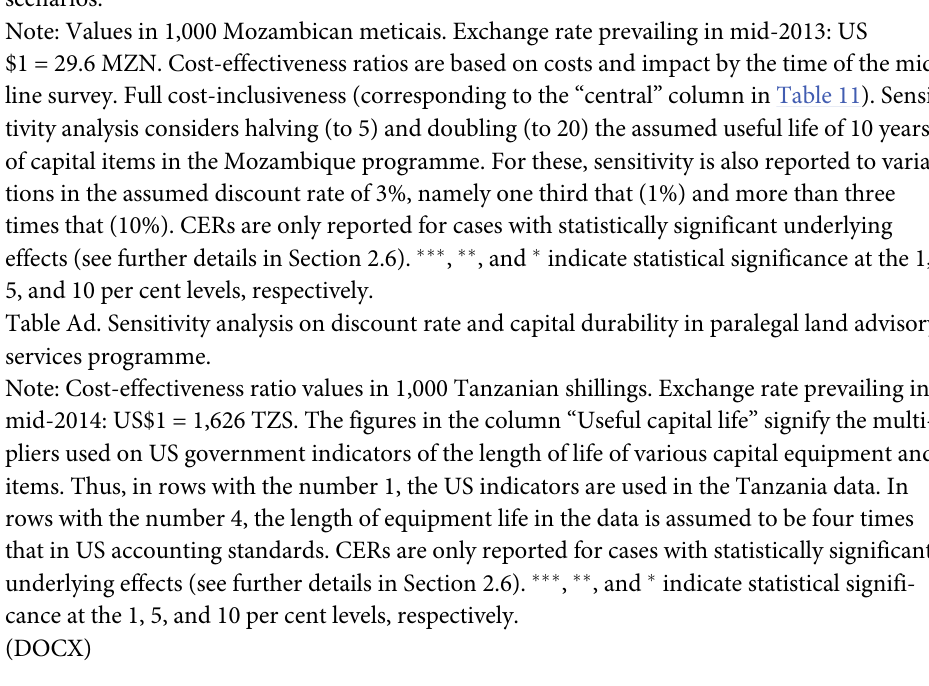
Table Ad. Sensitivity analysis on discount rate and capital durability in paralegal land advisory services